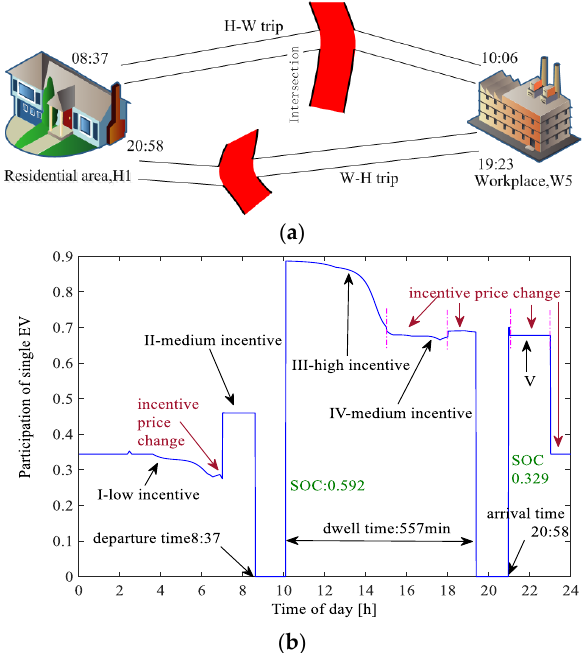
Figure 8. Probability of EV DR. ( a ) ‘ H-W-H ’ trip chain. ( b ) the demand response of a single EV.